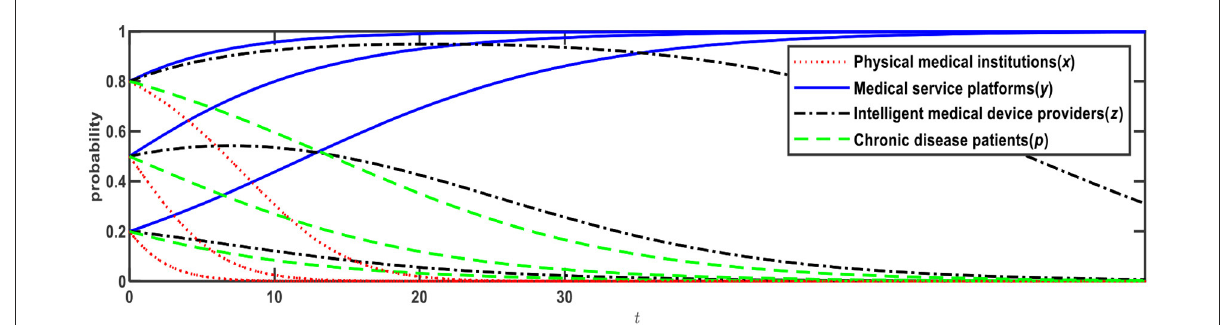
FIGURE5 Evolution of E4 (0,1,0,0).